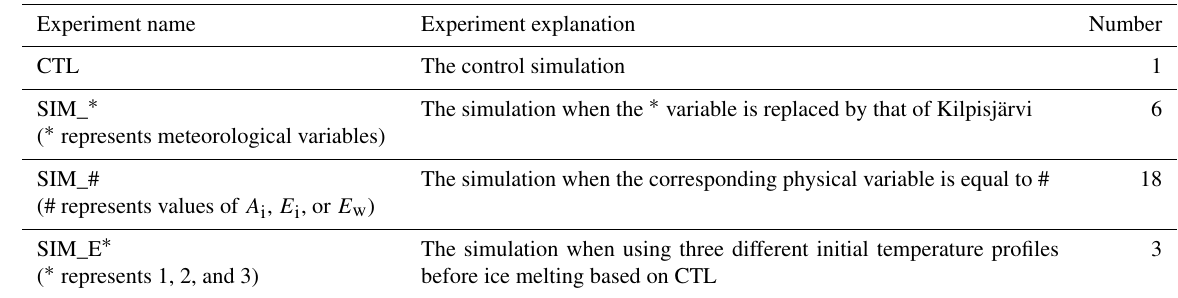
Table 2. Names, explanations, and numbers of all